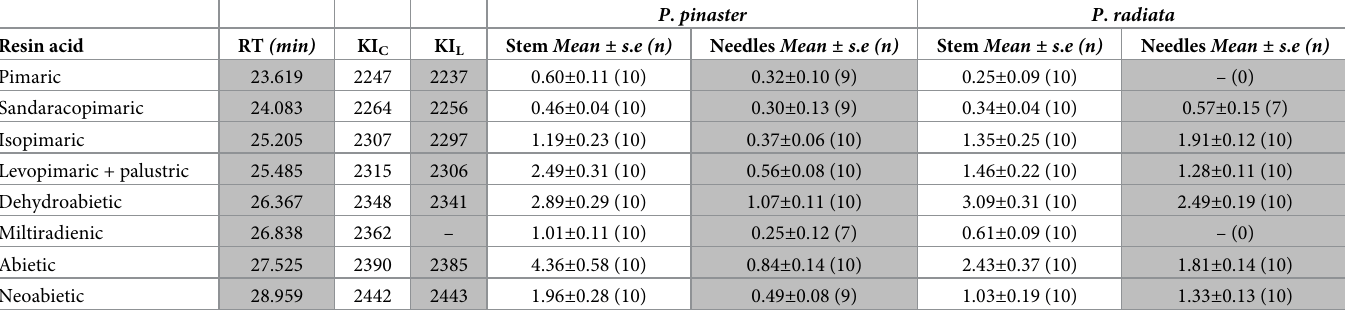
Table 2. Summary of the eight resin acids identified and quantified by GC-MS and GC-FID analyses, respectively, in the stem phloem and needles of 1-year-old seedlings of Pinus pinaster and P . radiata .